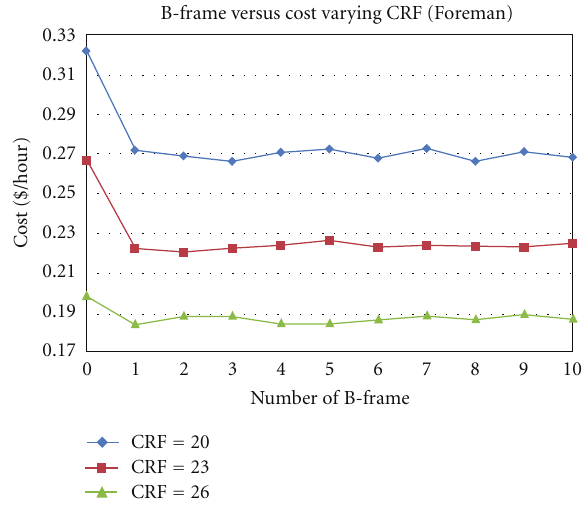
Figure 5: Encoding cost with varying B-frame number under di ff erent CRF settings